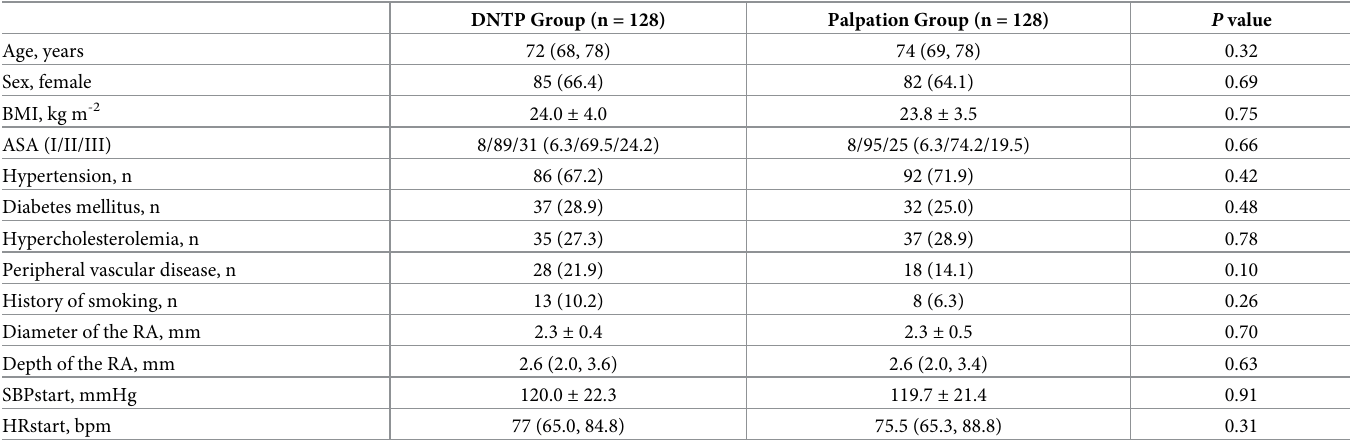
Table 1. Patient characteristics.